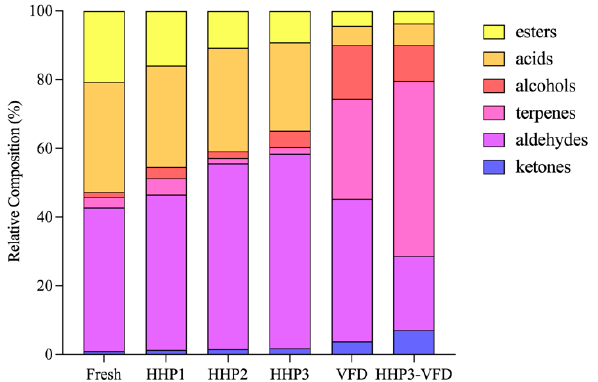
Figure 3. Relative composition (%) of classes of volatile components of blended juice treated by HHP and